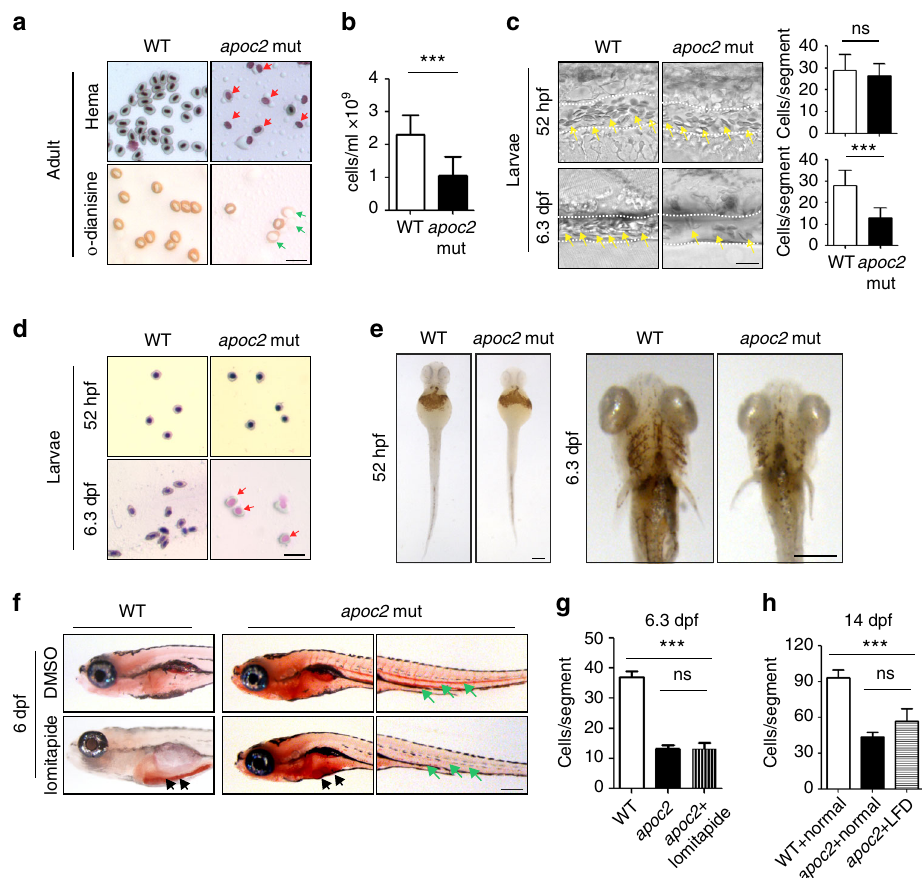
Fig. 1 Anemia in apoc2 mutant zebra fi sh. a Wright – Giemsa (Hema) and o-dianisine staining of peripheral blood cells from adult (18 – 20-month-old) male wild-type (WT) and apoc2 mutant zebra fi sh. b Quantitative results of peripheral blood cell count ( n = 11 for WT and n = 9 for apoc2 mutant groups). c Representative bright fi eld images and quantitative results of blood cell (yellow arrows) count in the caudal vein (outlined with white dashed lines) of WT and apoc2 mutants at 52 hpf ( n = 8 in WT and n = 9 in apoc2 mutant groups) and 6.3 dpf ( n = 11 for WT and n = 13 for apoc2 mutant groups). See also Supplementary Movies 1 and 2. d Wright – Giemsa staining of blood smears from WT and apoc2 mutants at 52 hpf and 6.3 dpf. Immature erythrocytes containing larger and less condensed nuclei are indicated with red arrows in a and d . Immature erythrocytes with weaker hemoglobin staining are indicated with green arrows in a . e o-Dianisine staining of 52 hpf and 6.3 dpf WT and apoc2 mutant embryos. f Effect of lomitapide: WT and apoc2 mutants were treated with 5 μ M lomitapide starting from 2 dpf until embryos were fi xed at 6 dpf for ORO staining. Black arrows point to intestinal lipid accumulation and green arrows to circulating lipids. g Blood cell counts in the caudal vein of WT, apoc2 mutants and apoc2 mutants treated with lomitapide at 6.3 dpf ( n = 5 in each group). h Blood cell counts in the caudal vein of 14 dpf WT, apoc2 mutants fed with normal diet and apoc2 mutants fed with low-fat diet (LFD) starting at 5 dpf ( n = 4 in WT and apoc2 mut groups each; n = 5 in apoc2 + LFD group). Scale bars, 20 μ m in a , c , and d , 100 μ m in e , and 200 μ m in f . Mean± SEM; *** P < 0.001 (Student ’ s